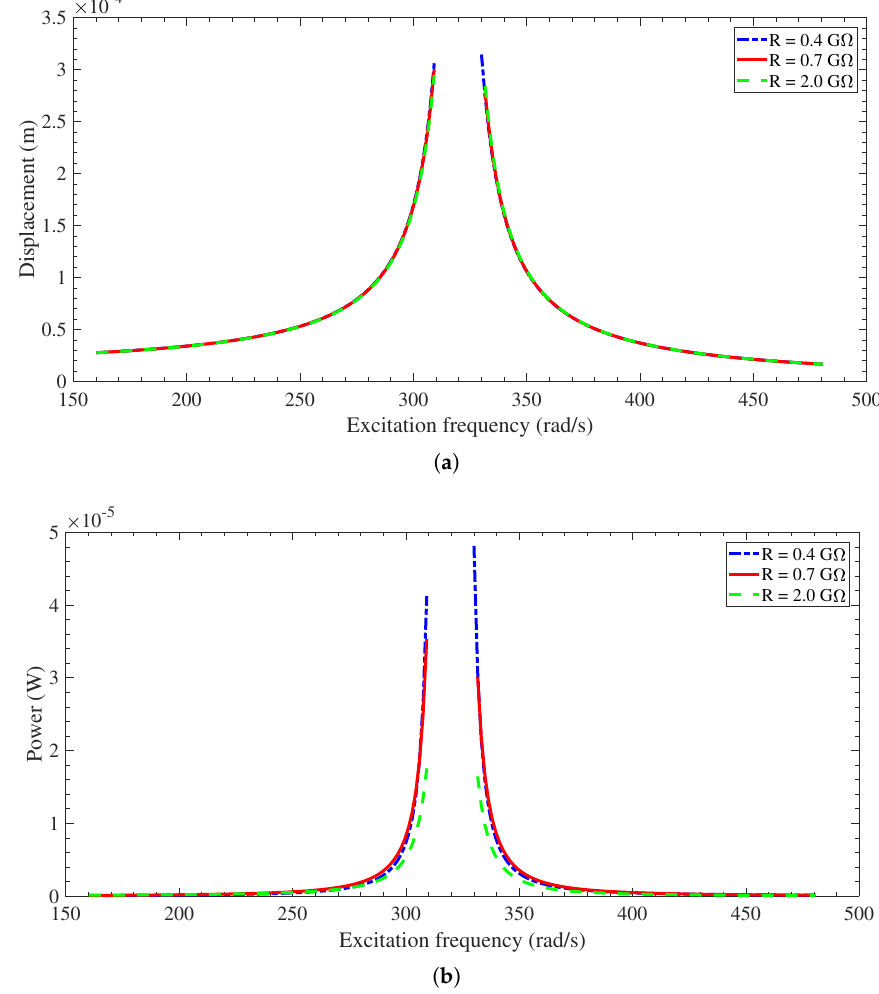
Figure 13. Frequency–response curves in terms of ( a ) displacement and ( b ) electrical harvested power for V et = 400 V and F = 3 m/s 2 .